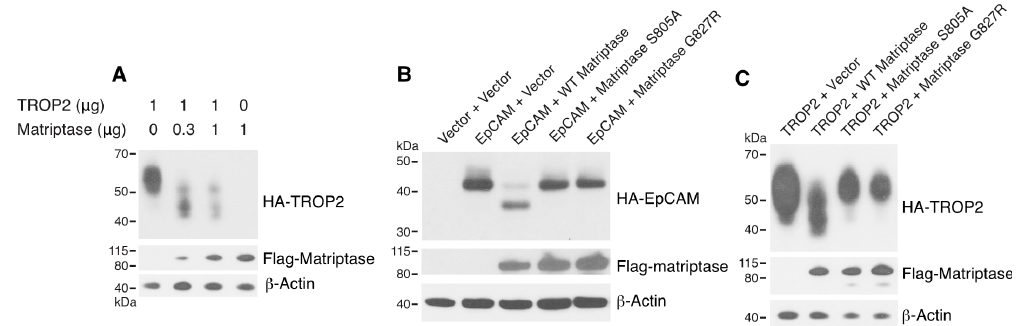
Figure 4. Active matriptase, but not inactive S805A or disease-associated G827R mutant matriptase, promotes cleavage of EpCAM and TROP2. 293T cells were transfected using Fugene 6 with fixed amounts of pcDNA3 encoding HA-TROP2 and varying amounts of Flag-matriptase expression plasmid ( A ), pcDNA3 encoding HA-EpCAM and plasmid encoding Flag-matriptase, Flag-matriptase S805A, or Flag-matriptase G827R ( B ), pcDNA3 encoding HA-TROP2 and plasmids encoding Flag-matriptase or mutants ( C ). 48 h after transfection cell lysates were prepared and resolved, and the indicated epitope-tagged proteins were analyzed via Western blotting using anti-HA and anti-Flag. Representative data from 1 of 3 experiments is shown.